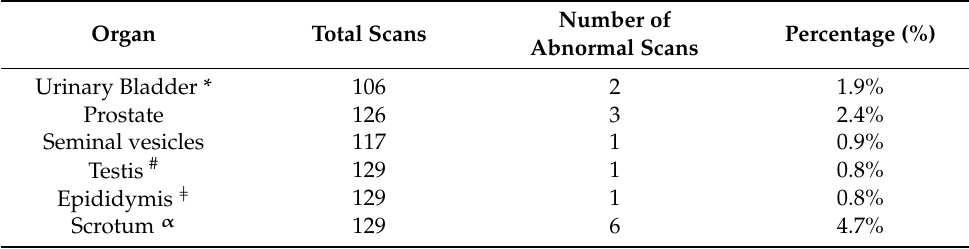
Table 2. Proportion of abnormal findings in particular organs at baseline.